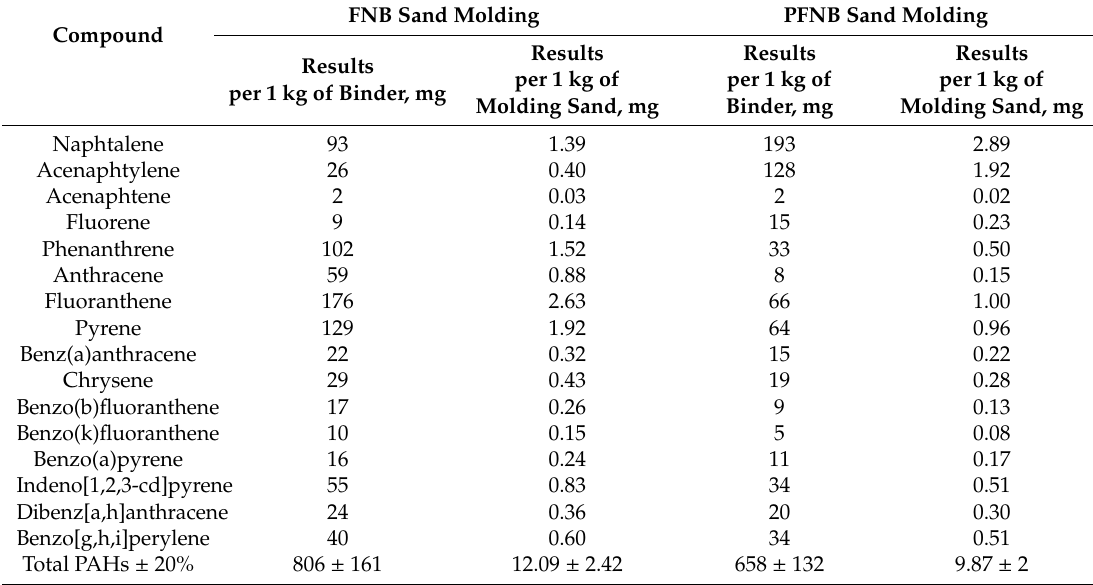
Table 4. QuantityofPAHscompoundsreleasedfromtheFNBandPFNBmoldingsandsduringthethermal decomposition (fresh sand).